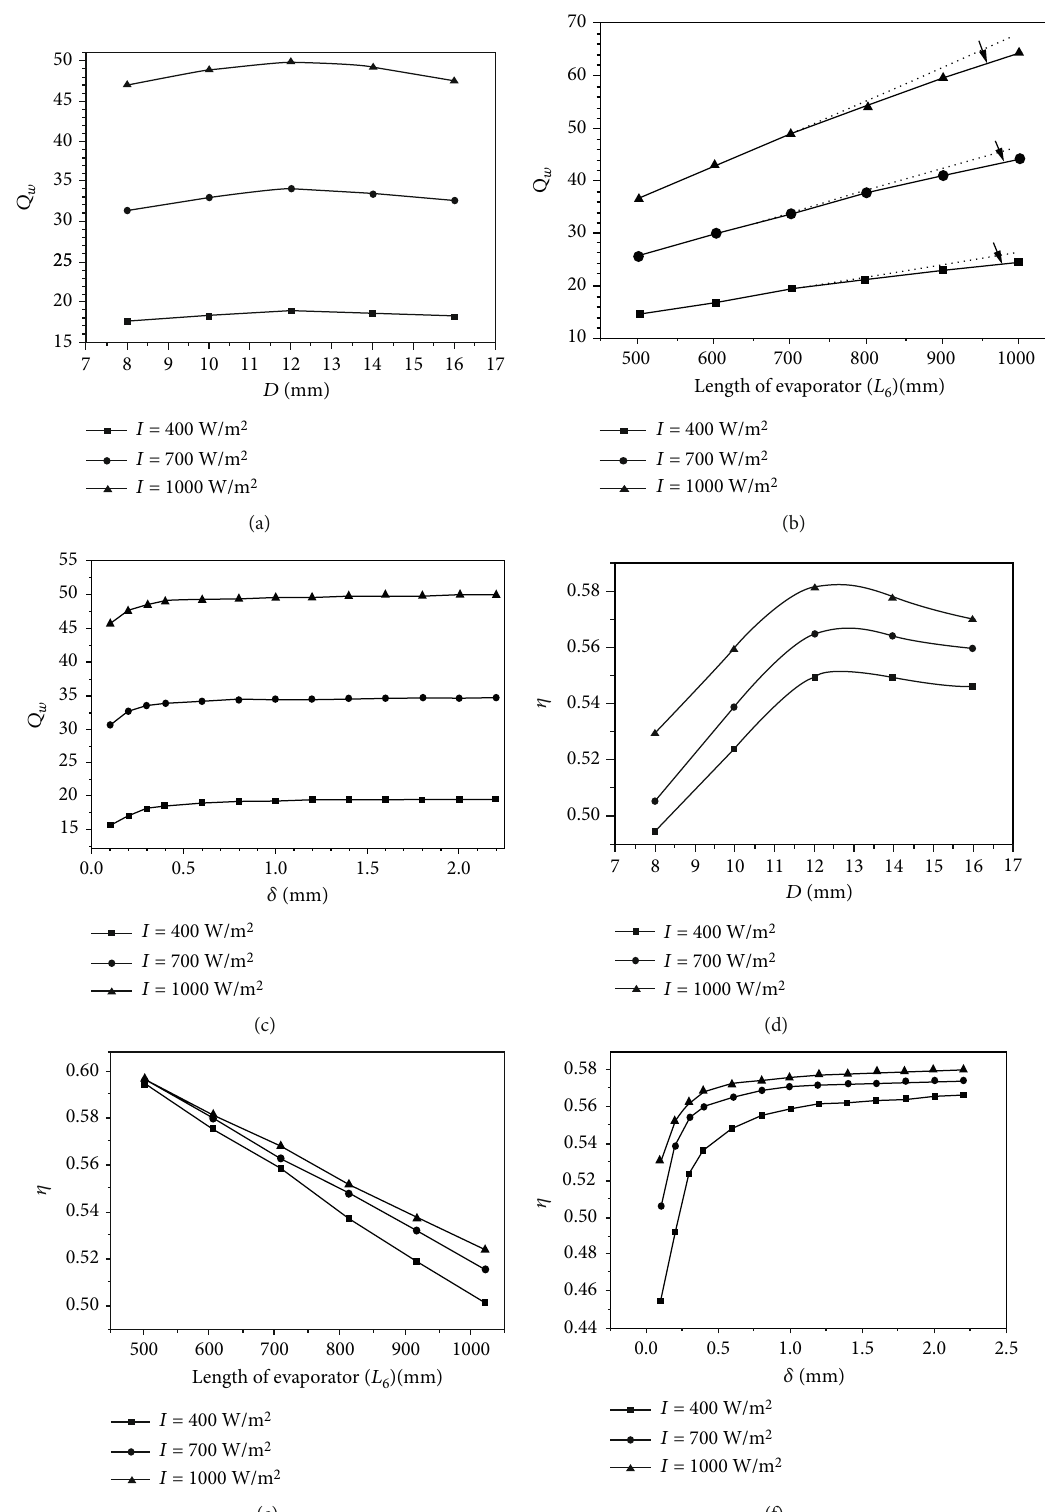
Figure 4: E ff ect of the heat pipe diameter, evaporation length, and collector plate thickness on the heat transfer and e ffi ciency